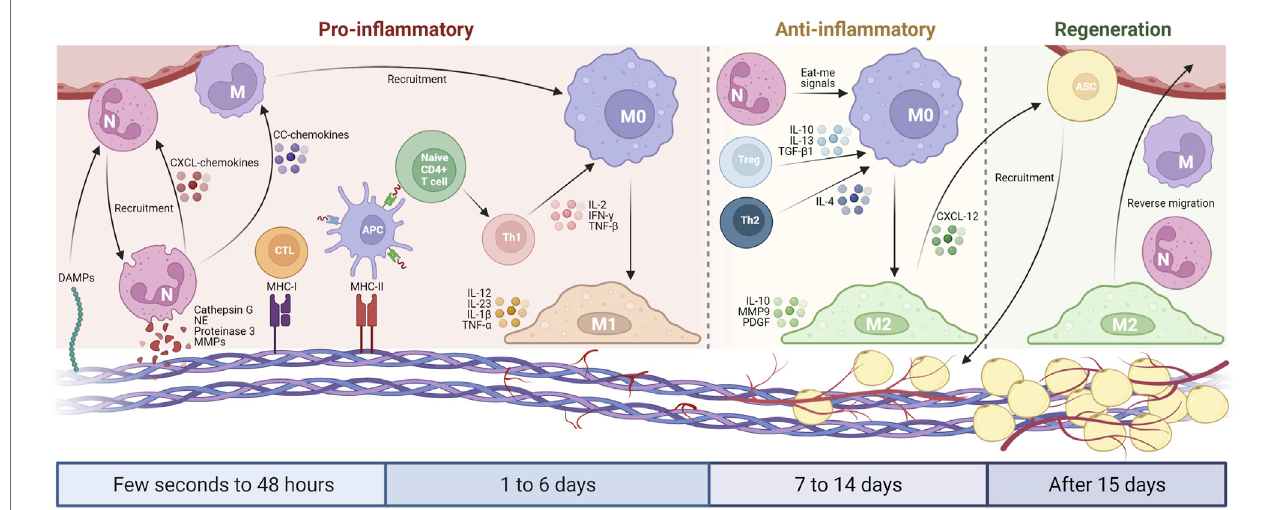
FIGURE1 | Schematic diagram of thehost in fl ammatorycell implantationin AAM.From afew seconds to48 h, DAMPs cause theinitialrecruitment ofneutrophils, which secrete serine proteases and MMPs to cleave AAM components. Neutrophils produce CXCL-chemokines and CC-chemokines, which recruit more neutrophils and monocytes from the circulation. The remaining MHC molecules in AAM activate lymphocytes that promote M1 macrophage polarization via pro-in fl ammatory cytokines during 1 – 6 days after implantation. From day 7 – 14, the host blood vessels begin to grow in the AAM, thereby inducing adipogenesis. Neutrophils, Treg cells, and Th2 lymphocytes subsequently promote M2 macrophage polarization that translates pro-in fl ammatory into an anti-in fl ammatory environment. After 15 days, the in fl ammation level of AAM gradually decreased, the neovascularization further developed, and the adipogenesis process continued with the participation of M2 macrophages. Created with